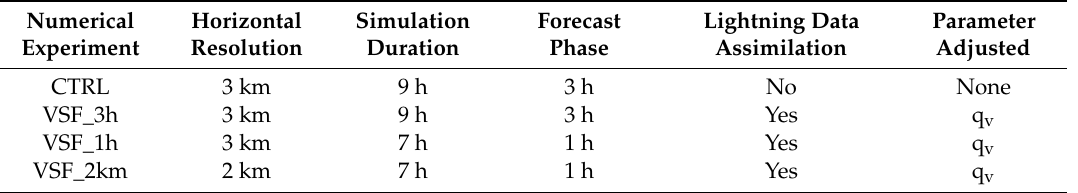
Table 2. Numerical experiments at fine horizontal resolution. q v is the water vapor mixing ratio. The assimilation phase is 6 h long for all numerical